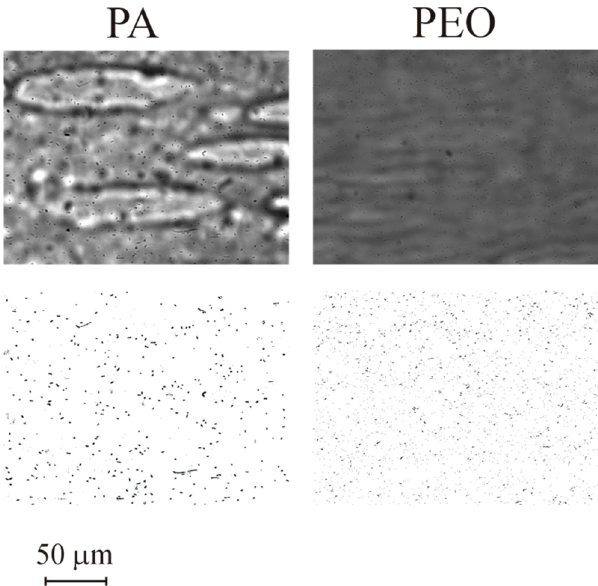
Figure 6. Images for adhesion in different materials for t = 1800 s: PA and PEO. Top row is before and bottom row after image processing. Results obtained for nominal wall shear stress of 0.01 Pa.